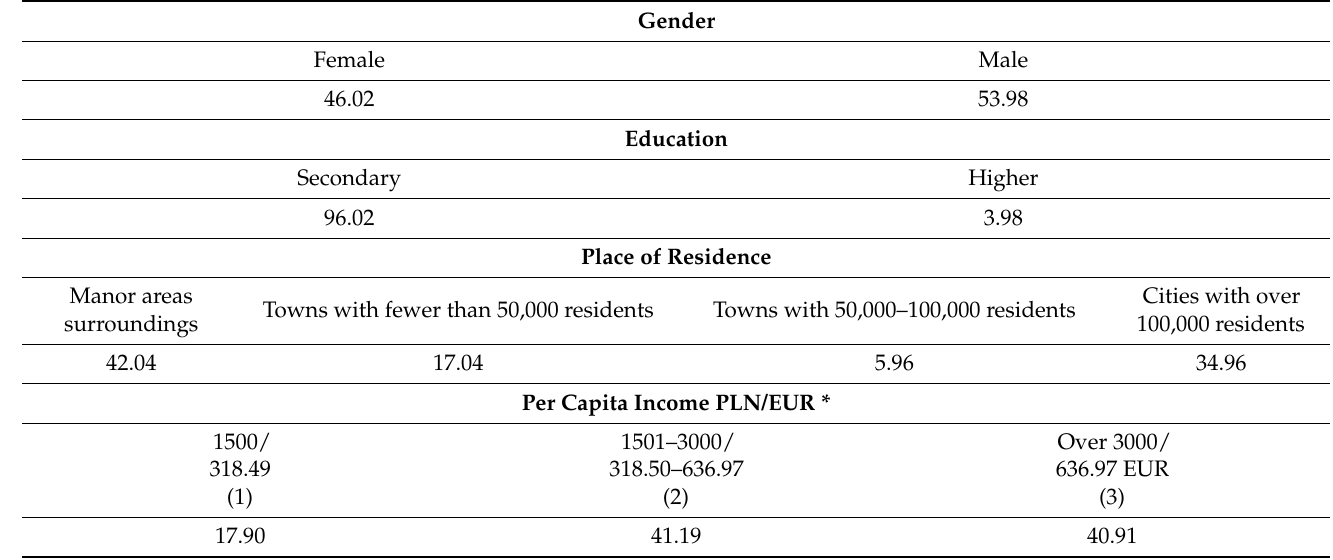
Table 1. Socio-demographic structure of the research group, accounting for selected characteristics